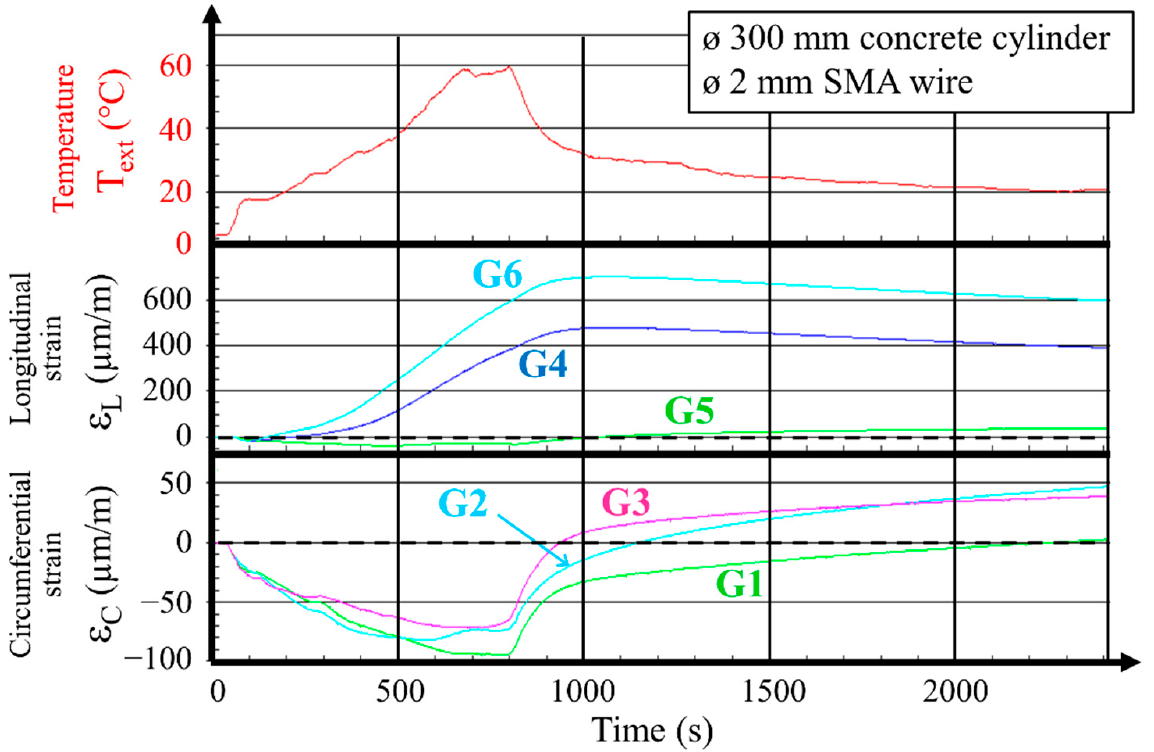
Figure 3. Measurements of wire temperature Text, longitudinal strain ε L, and circumferential strain ε c of concrete during the process of testing a 300 mm diameter hollow cylinder wound with a 2 mm diameter SMA wire without predeformation (circumferential gauges—G1, G2, and G3; longitudinal gauges—G4, G5, and G6). Note that gauge G5 was not working for all tests without predeformation.